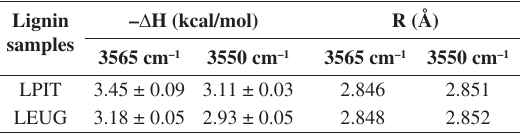
Table 6. Enthalpy-OH wavenumber shift and hydrogen bond distances values for the lignins studied. Lignin – Δ H samples